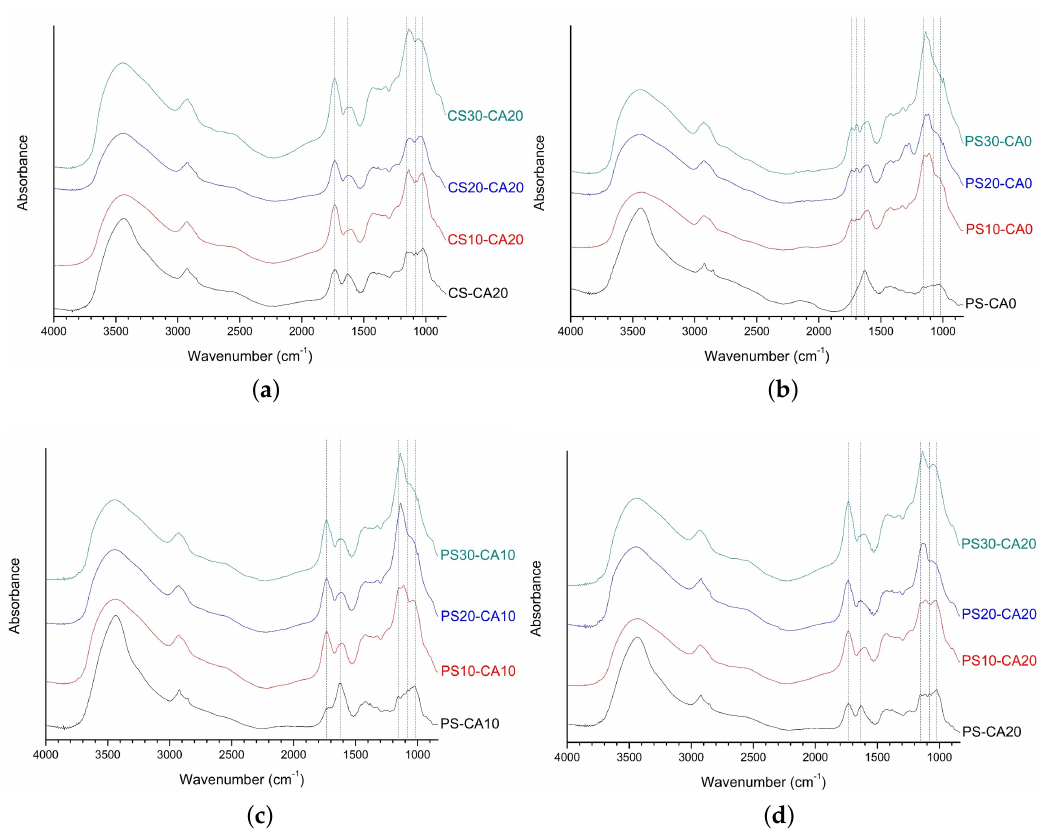
Figure 4. The FT-IR spectra of polysaccharide-based SAPs: ( a ) CS-CA20, CS10-CA20, CS20-CA20, CS30-CA20; ( b ) PS-CA0, PS10-CA0, PS20-CA0, PS30-CA0; ( c ) PS-CA10, PS10-CA10, PS20-CA10, PS30-CA10; ( d ) PS-CA20, PS10-CA20, PS20-CA20,